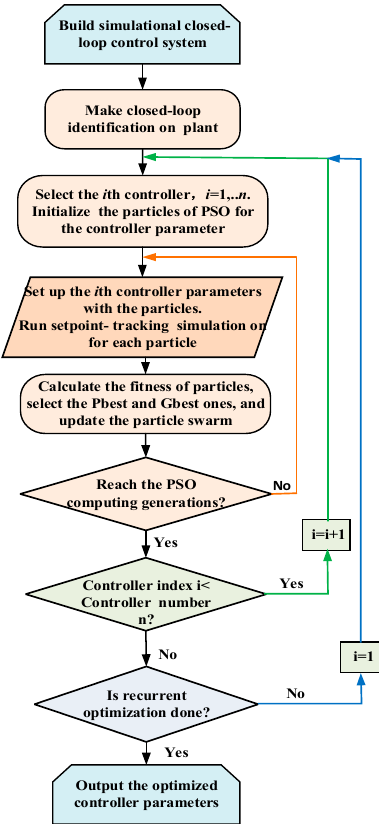
Figure 3. The working flow of PSO-based recurrent closed-loop optimization method (PSO-RCO)